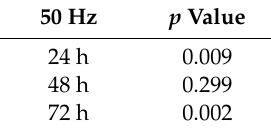
Table 3. The p -value of the percentage of viable CT2A cells after the exposure to a 100 µ T EMF at 50 Hz. 50 Hz p